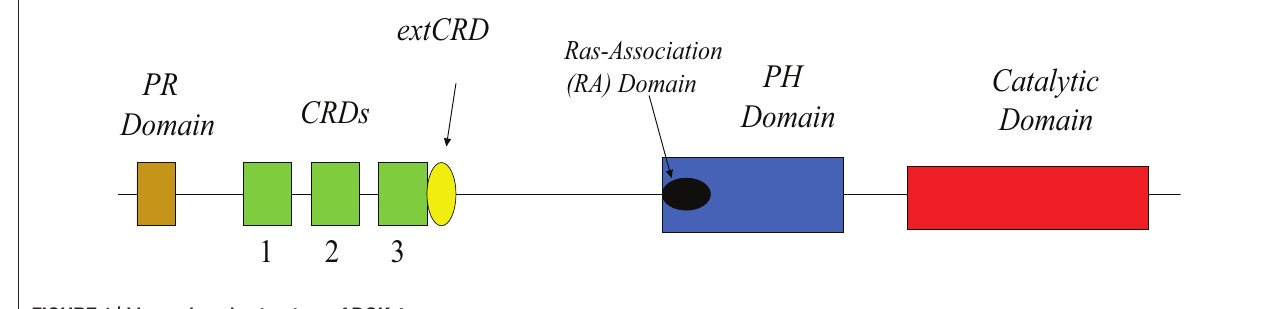
FIGURE 1 | Linear domain structure of DGK- θ